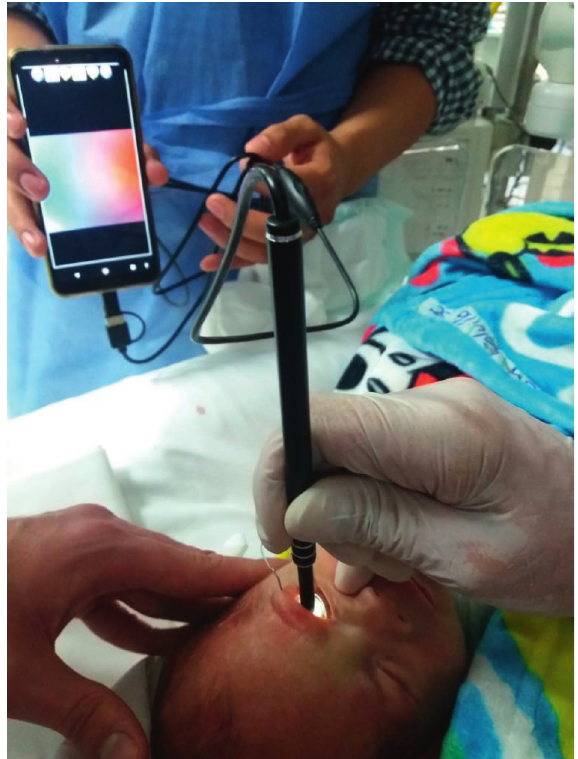
Figure 1: Right eye fundus exploration in a nonsedated preterm infant using the portable